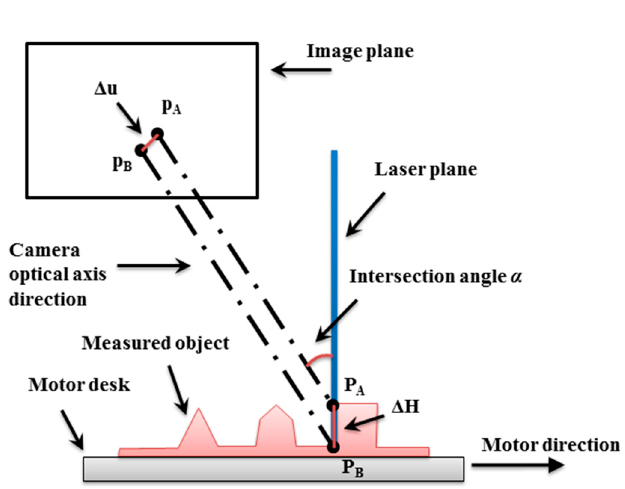
Figure 3. The resolution analysis in depth direction.